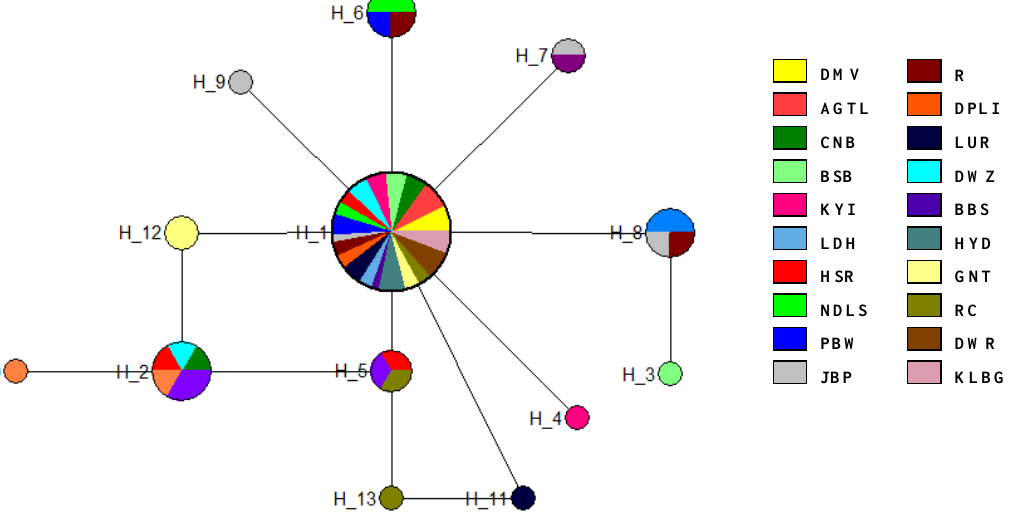
Figure 5. Median-joining haplotype network of M. vitrata in India based on mitochondrial COI gene. The circle areas are proportional to haplotype frequencies, while the color portions represent the proportions of the same haplotype occurring in each geographical region.